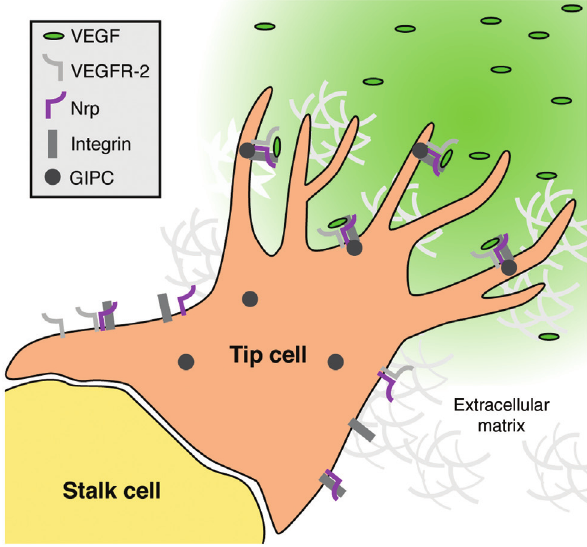
Figure 2 Nrp critically modulates endothelial tip cell function. Nrp is highly expressed in endothelial tip cells where it promotes